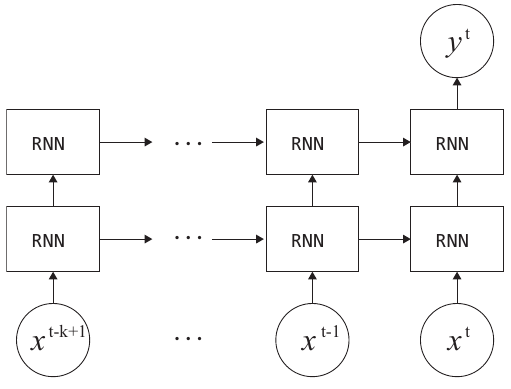
Figure 7. Recurrent neural network (RNN)-based architecture used for the proposed surface type classification. In this study, we employed long short-term memory (LSTM) and gated recurrent units (GRU)